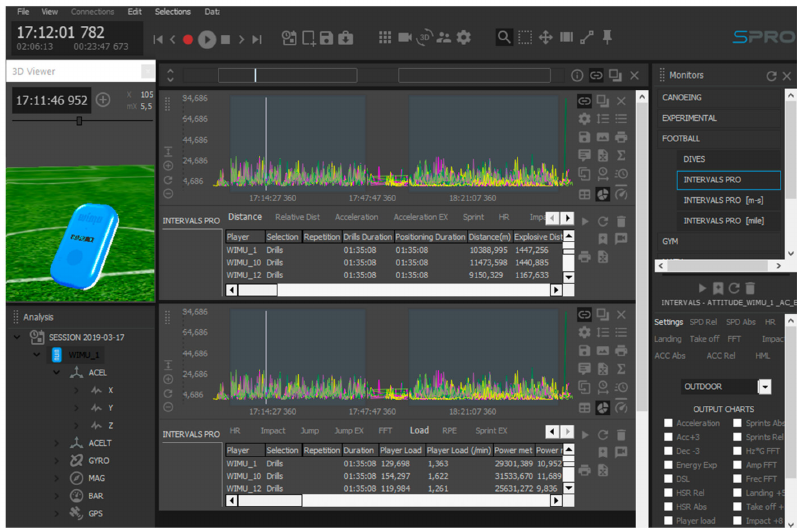
Figure 2. Data collected by the tracking system on the Intervals Pro report (RealTrack Systems, Almer í a, Spain), which were used to calculate the locomotor e ffi ciency ratio.